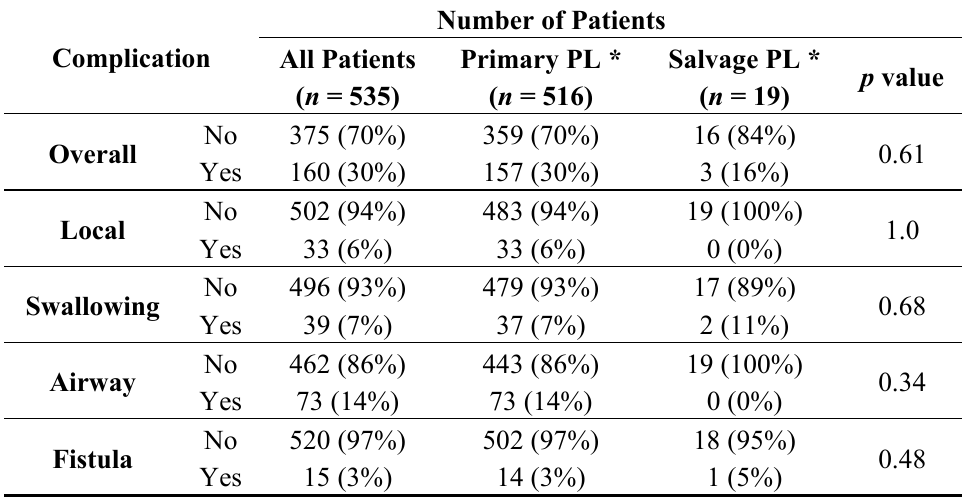
Table 3. Postoperative complications after partial